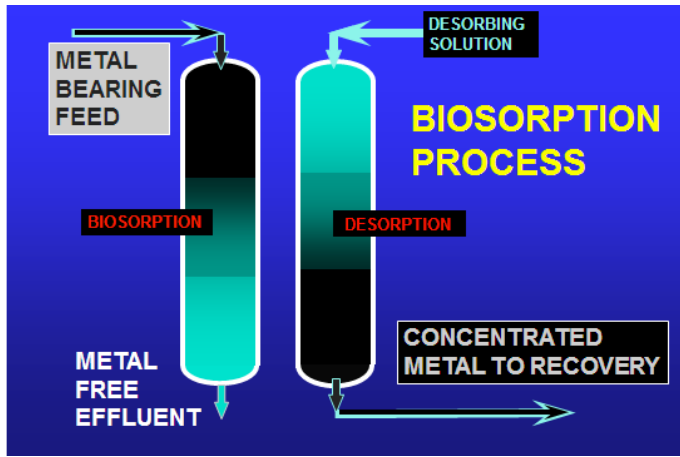
Fig. 1. A molecular scheme for a detailed understanding of the biosorption Fig. 1.